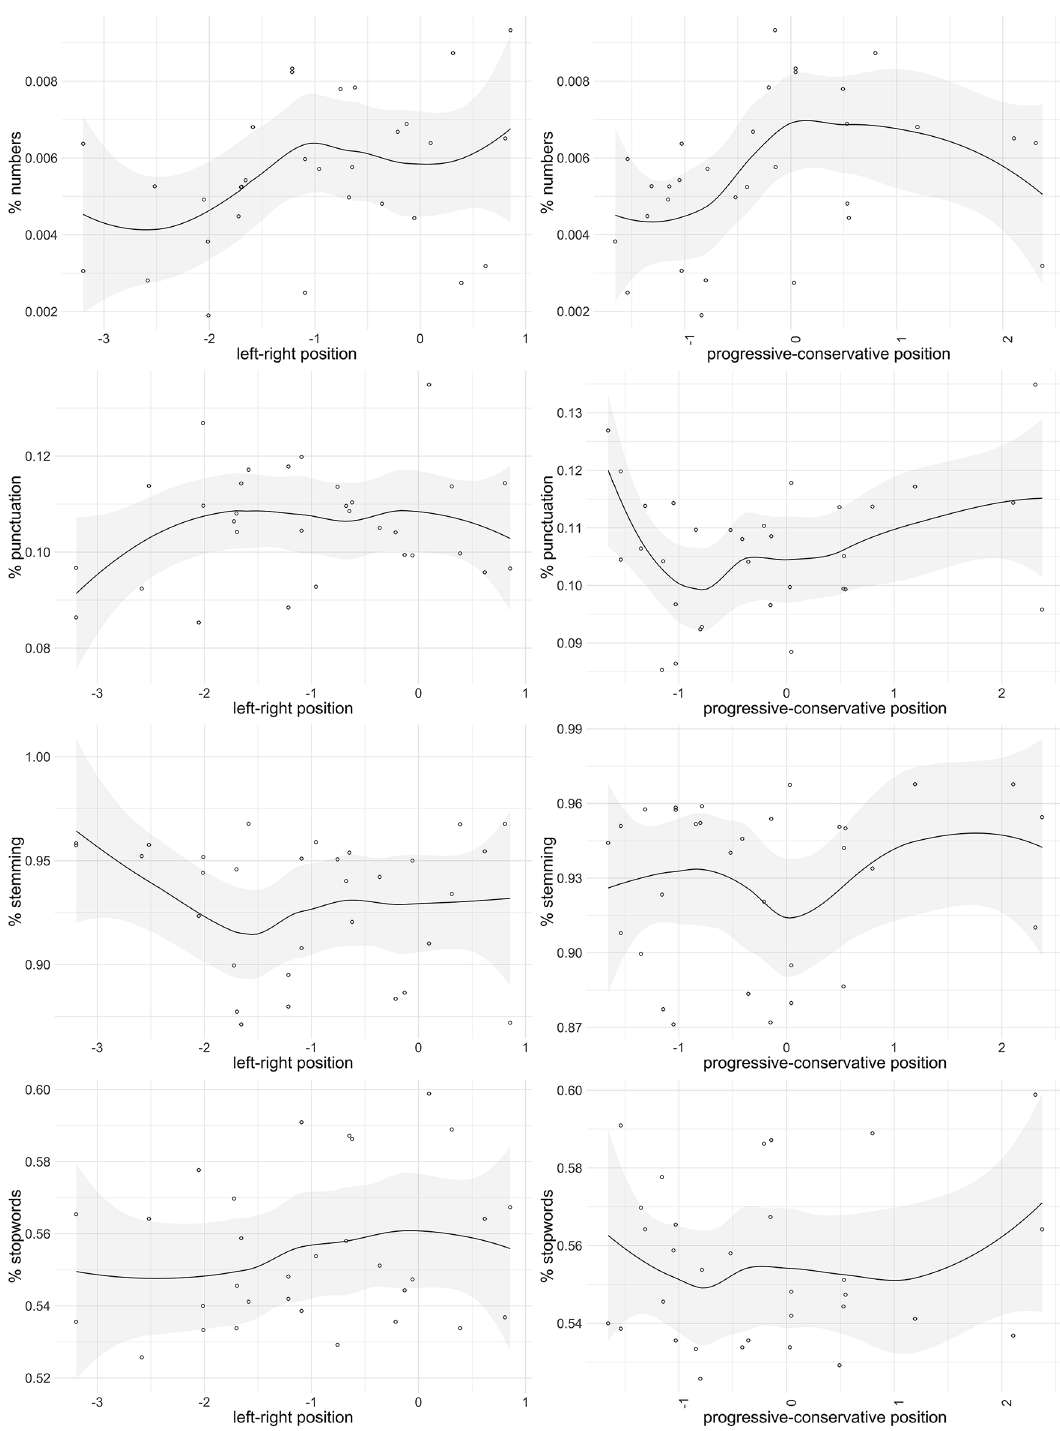
Figure 2. Average use of numbers, punctuation, stop words by politicians in the European Union, sorted by ideological left-right and progressive-conservative positions. Note. This figure displays the average scores on each four preprocessing dimensions (numbers, punctuation, stemming and stop words) for EU politicians (heads of government and group leaders in the European Parliament), sorted by left-right and progressive-conservative